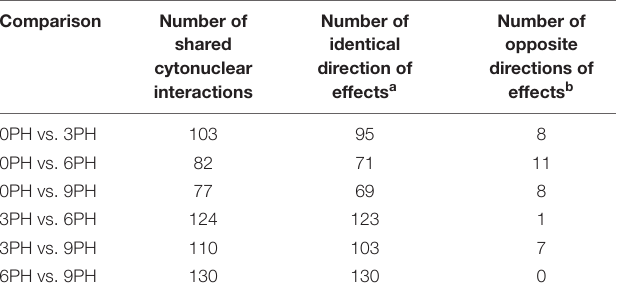
Comparison Number of